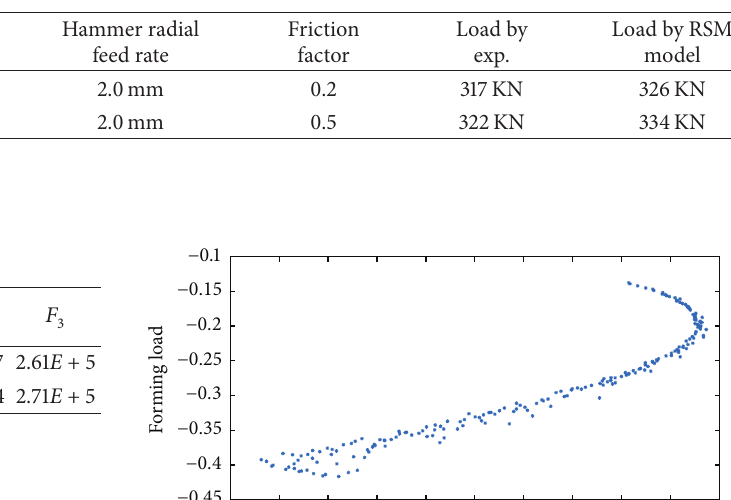
Table 3: Comparison of the forming load in the radial forging process.